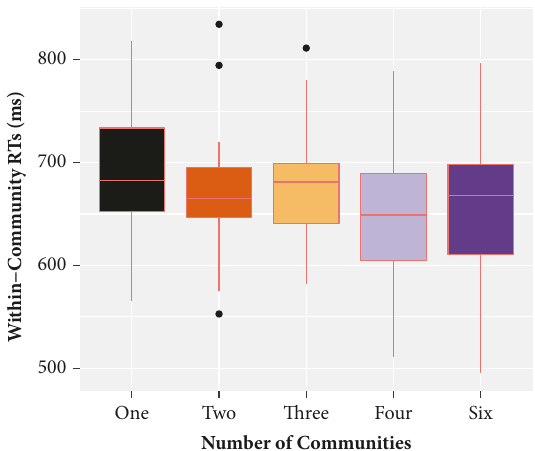
Figure 3: Boxplots ( N = 100 participants) illustrating intra- community RTs for each graph type (1, 2, 3, 4, or 6 communities). The greatest general facilitation effects were found for the graph type consisting of 4